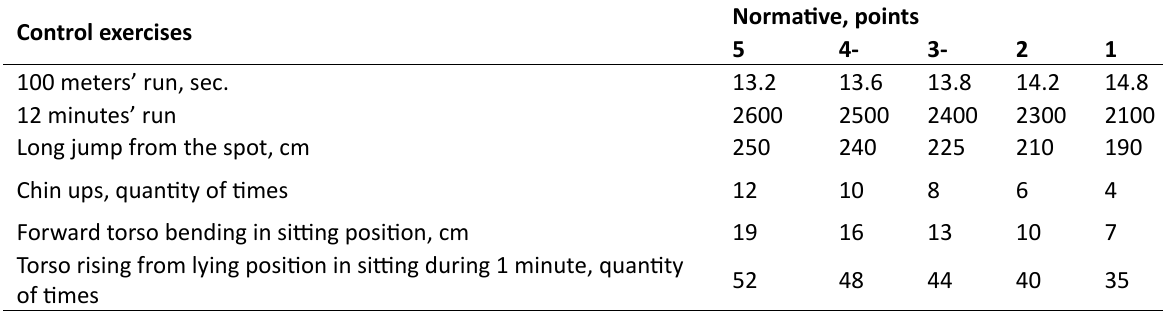
Table 1. Criteria for first year students’ physical fitness assessment Control exercises